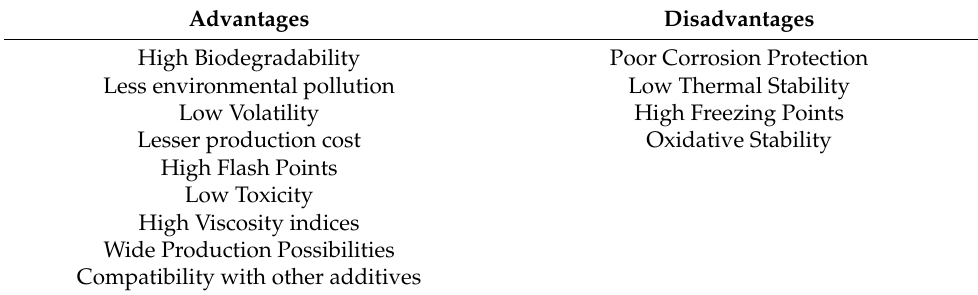
Compatibility with other